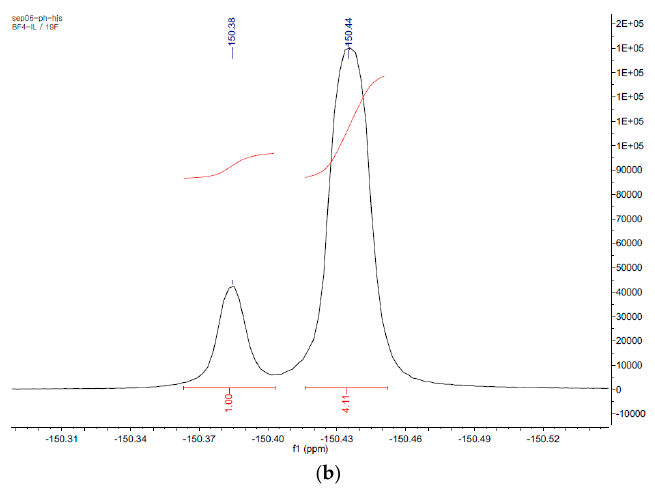
Figure 9. 19 F-NMR spectrum of sucrose crystals precipitated from BMImBF 4 . ( A. gigas extraction solution/ILs: 3 mL/3 mL (1:1 v / v ), solvent: D 2 O) ( a ) sucrose crystal, and ( b ) BMImBF 4 .